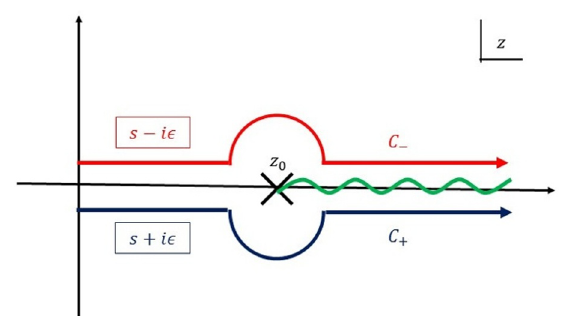
Figure 4 . Integration contours C + and C (cid:0) on the Borel